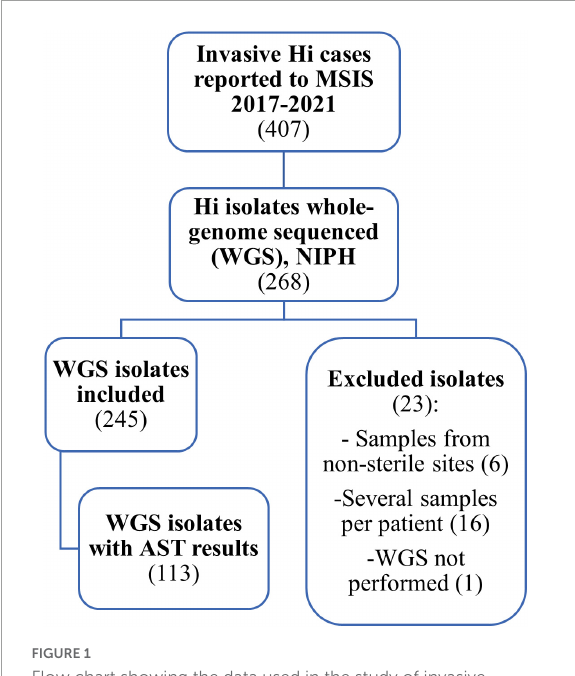
FIGURE1 Flow chart showing the data used in the study of invasive Haemophilus influenzae in Norway 2017–2021. Of 407 cases reported to the Surveillance System for Communicable Disease in Norway (MSIS), we identified 268 samples submitted to the national reference laboratory at the Norwegian Institute of Public Health (NIPH) that were whole-genome sequenced (WGS). Of these, 245 isolates were included in the study. Data on antibiotic susceptibility testing (AST) was only available for 113 of the 245